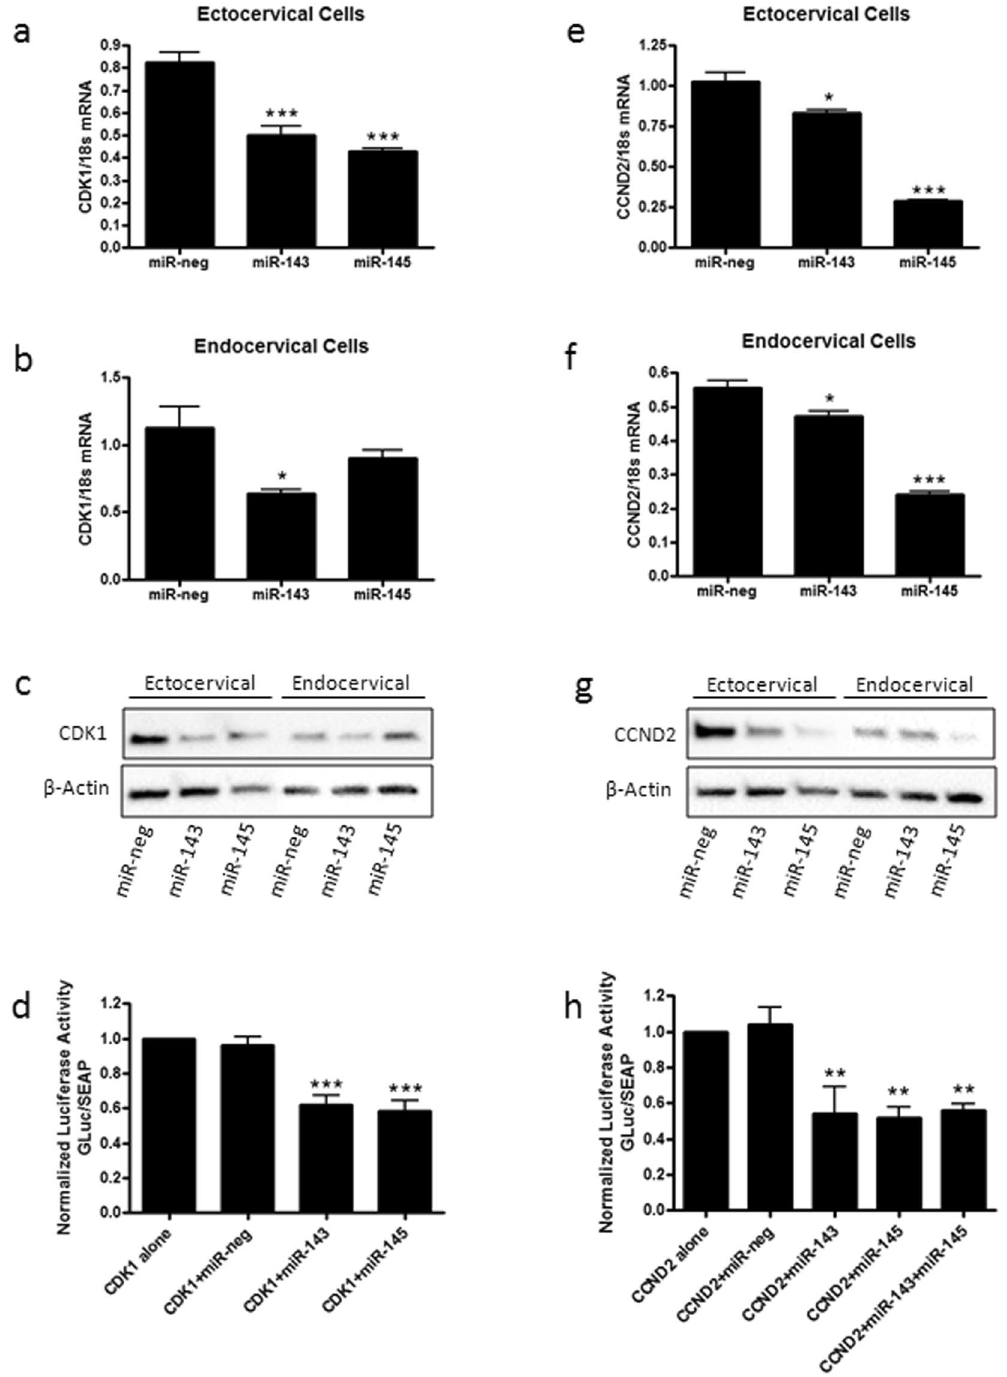
Figure 8. miR-143 and miR-145 repress genes that regulate the cell cycle. Ectocervical and endocervical cells were transfected with miR-negative control (miR-neg), miR-143 or miR-145 and expression of downstream target genes were measured by QPCR and western blot. Cyclin dependent kinase 1(CDK1), was significantly decreased by both miR-143 and miR-145 in ectocervical cells ( a ). In endocervical cells, only miR-143 transfection resulted in a decrease in CDK1 expression ( b ). Protein expression of CDK1 was reduced by miR-143 and miR-145 in ectocervical cells and by miR-143 only in endocervical cells ( c ). 3 ′ UTR luciferase assays confirmed that CDK1 is a direct target of miR-143 and miR-145 ( d ). Cyclin D2 (CCND2) was repressed by overexpression of both miR-143 and miR-145 in ectocervical ( e ) and endocervical ( f ) cells. CCND2 protein expression was reduced in miR-143 and miR-145 transfected ectocervical and endocervical cells ( g ). 3 ′ UTR luciferase assays showed that CCND2 is a direct target of both miR-143 and miR-145 ( h ). 3 ′ UTR assay results are expressed as a ratio of Gaussia Luciferase (GLuc) activity over Secreted Alkaline Phosphatase (SEAP) which has been normalized to cells transfected with the plasmid alone. Values are mean ± SEM. * p < 0.05, ** p < 0.01, *** p <